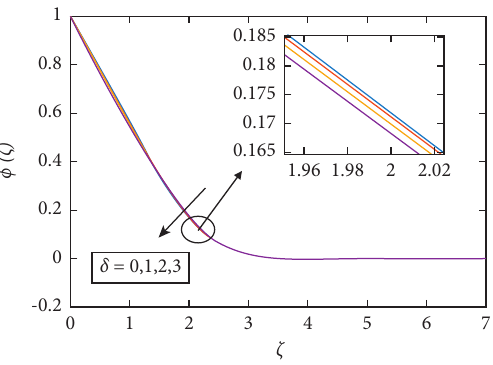
Figure 18: Nb variation on φ ( ζ ) .